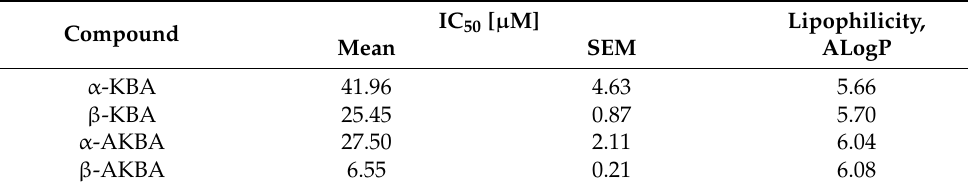
Table 5. Cytotoxic efficacies of individual 11-keto-boswellic acid (KBA) and acetyl-11-keto-boswellic acids (AKBA) isomers against MDA-MB-231 cells in vitro. XTT assay, 72 h, n = 3 (all biological replicates were performed in triplicates). ALogP values calculated with BIOVIA Draw Ver. 20.1 soft- ware (Dassault Systemes, V é lizy-Villacoublay, France). Half maximal inhibitory concentration (IC 50 ) values of β -KBA and β -AKBA from a previously published study [27]. Data are expressed as mean ± standard error of the mean (SEM). IC 50 [ µ M] Lipophilicity, Compound Mean SEM ALogP α -KBA